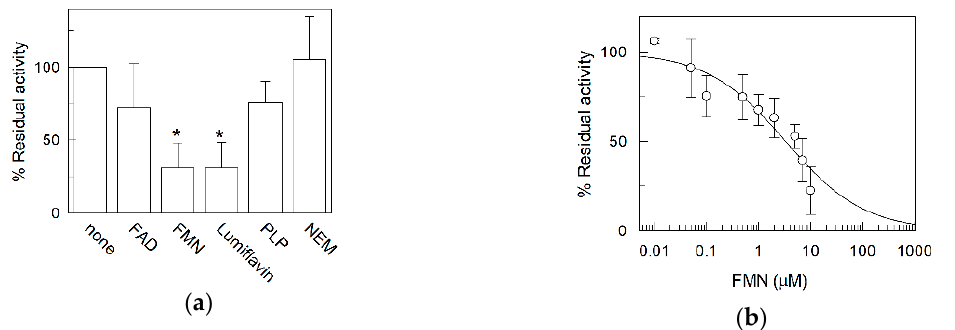
(cid:48) -phosphate (PLP) or N-Ethylmaleimide